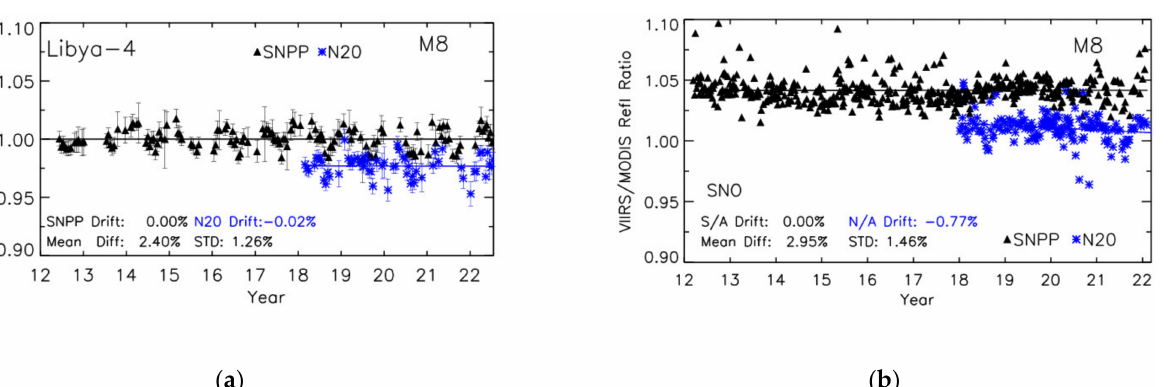
Figure 5. Normalized reflectance trends for SNPP and NOAA20 VIIRS M7 obtained from the Libya-4 ( a ), Dome C ( b ), SNO with Aqua MODIS ( c ), and DCC ( d ). One example in the short-wave infrared (SWIR) spectral region, band M8 (1.24 µ m), is shown in Figure 6. Results from the Dome C site are excluded due to their large fluctuations in the trends. The SWIR band trends for the Libya-4 site show relatively larger seasonal fluctuations than the VIS and near-IR bands, which is likely due to the combined impact of the surface BRDF and atmospheric absorption. For the DCC approach, the SWIR reflectance is highly dependent on wavelength. As discussed in the methodology, to further reduce seasonal fluctuations, an empirical SWIR band-dependent DCC BRDF model is applied instead of the Hu DCC BRDF, which is effective only for the VIS and near-IR bands. Results indicate there is an excellent stability (<1%) for the SWIR bands. The relative biases between SNPP and NOAA20 SWIR bands are further reduced to approximately 2%, compared with 4% for the near-IR bands and 4–6% in the VIS bands.